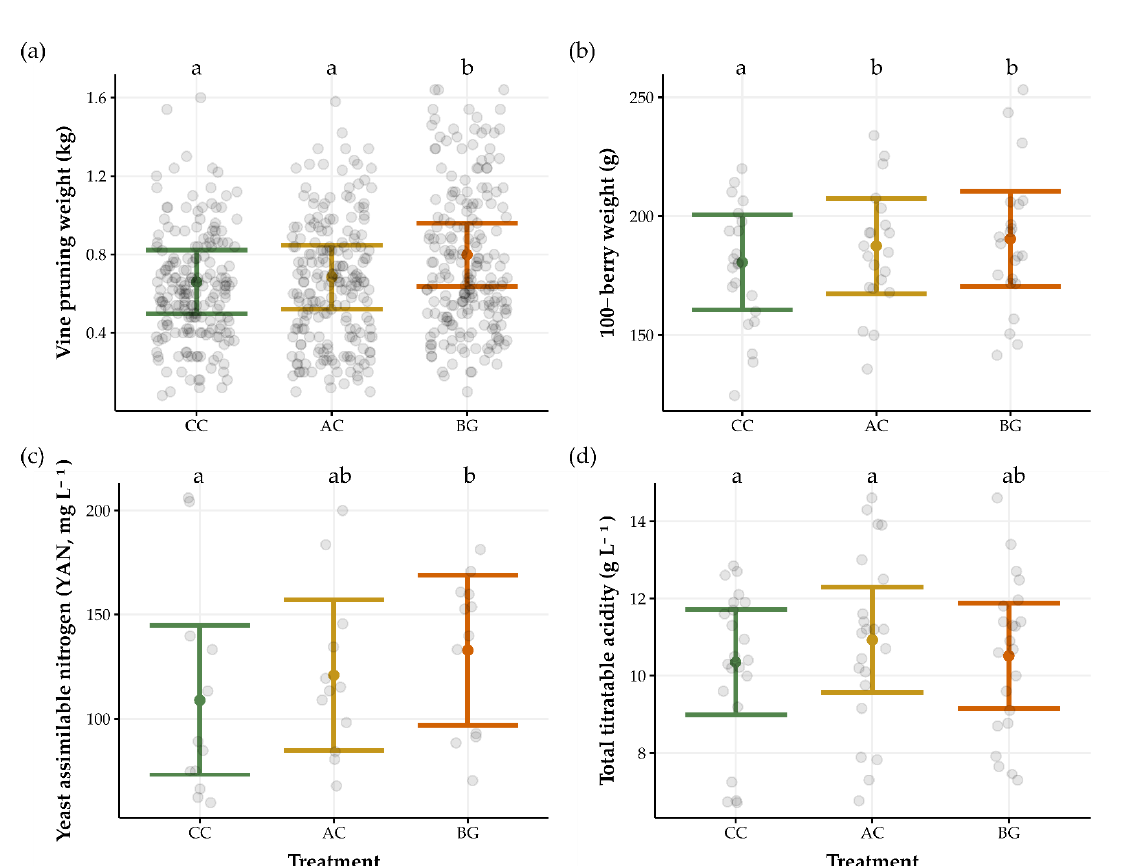
Figure 6. The observed and model-predicted values of each vine vitality parameter: ( a ) vine pruning weight, ( b ) 100-berry weight, ( c ) yeast assimilated nitrogen and ( d ) total titratable acidity. The mean values of each treatment are represented by a center point with the 95% confidence interval bars, with complete cover (CC) as the baseline model intercept, and alternating cover (AC) and bare ground (BG) as additions thereafter. Significant differences in treatments ’ impact, affirmed by likelihood ratio tests, are represented by different lettering.